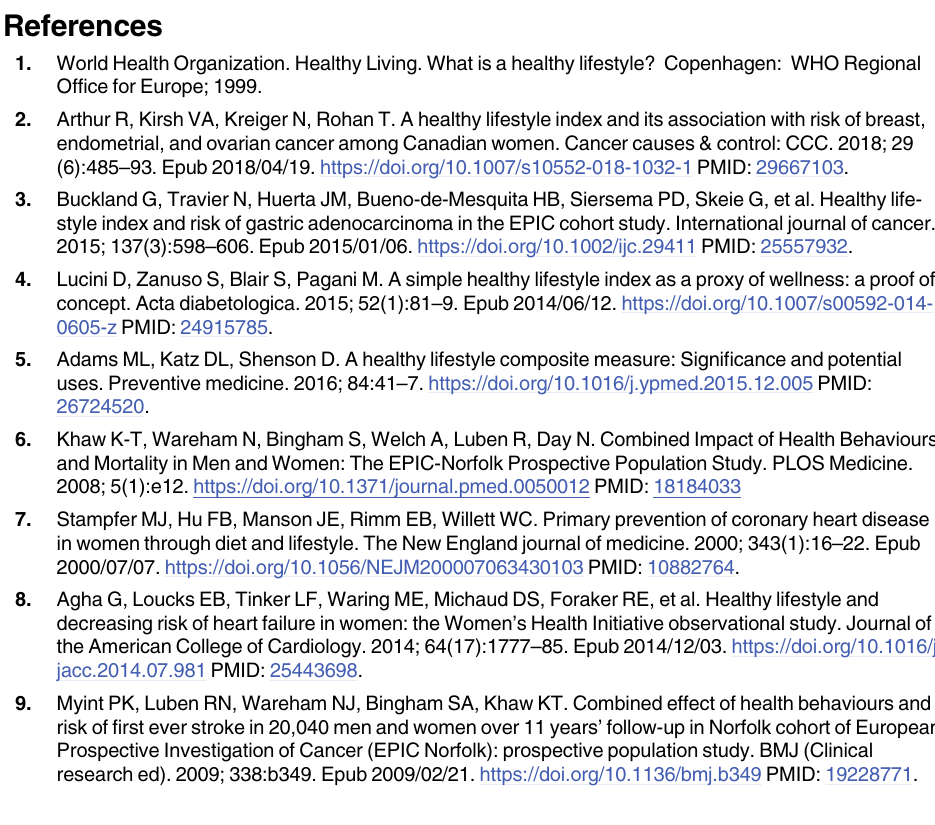
S1 Fig. Proportions (%, 95%-CI) of healthy behaviour factors according to educational level. S1 Table. Proportions of individual healthy behavior factors among men aged 25–69 years according to age. S2 Table. Proportions of individual healthy behavior factors among women aged 25–69 years according to